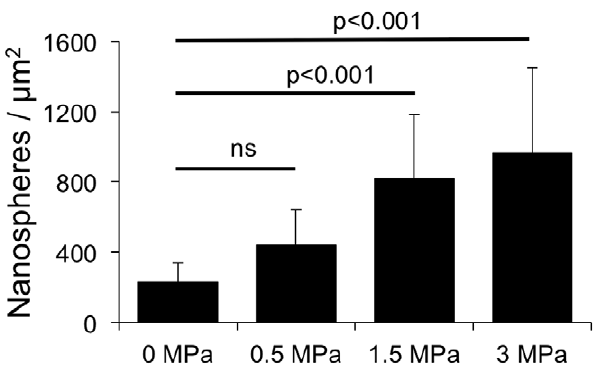
Figure 6. Delivery of myocardial UMS in mice. UMS-mediated myocardial delivery of fluorescent nanospheres was measured and quantified by fluorescence microscopy. Myocardial delivery of fluores- cent nanospheres with UMS was feasible in mice and demonstrated a dose-dependent